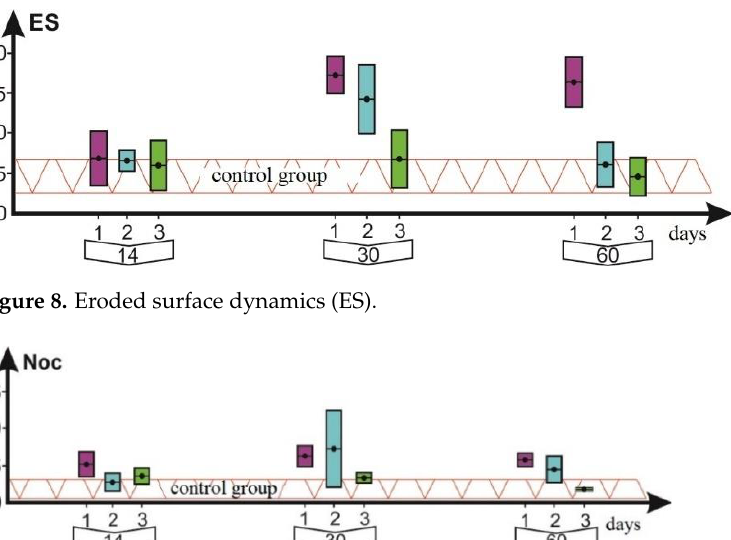
10 of 14 Figure 6. Changes to parameter N.Ob. The designations and colors on the graph correspond to those shown in Figure 4. The analysis of changes in parameters TT, ES, and N.Oc shows their more complex temporal dynamics. The dynamics of the parameter TT (the vertical axis represents thickness of the trabeculae in microns) is shown in Figure 7 as an example. It is impossi- ble to unequivocally interpret the increase in their mean values in group 3 over groups 1 and 2 overtime. Moreover, by the 60th day, the values of the TT parameter are aligned in the second and third groups. Apparently, the application of the antioxidant layer is not critical. The application of the calcium – phosphate layer has a more significant effect on its dynamics. Figure 7. Trabeculae thickness dynamics. The colors and designations are the same as for Figure 4.